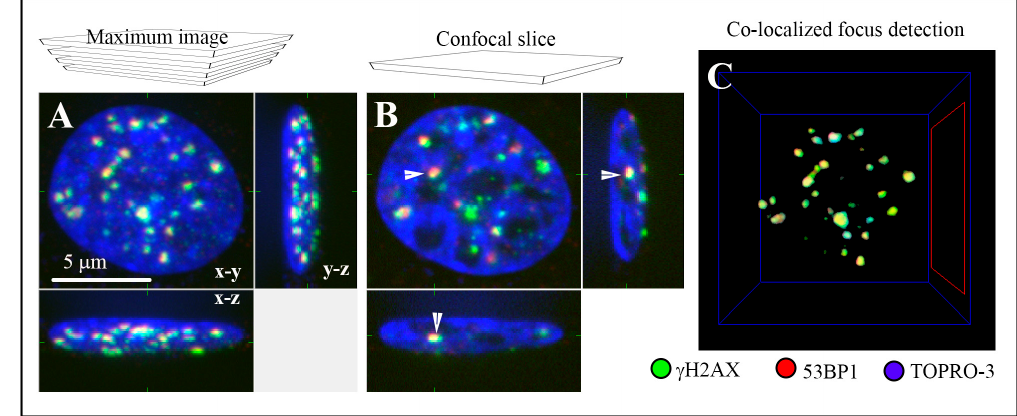
Figure 1. The ability of immunofluorescence confocal microscopy to quantify DSBs (Double Strand Breaks) in cells incubated with nanoparticles or incubated with nanoparticles and consecutively irradiated. DSBs were quantified by the means of immunofluorescence detection of co-localized γ H2AX (green) and 53BP1 (red) repair foci, the DSB markers. The nucleus of an illustrative U87 cell exposed to 2 Gy of γ -rays and spatially (three-dimensionally = 3D) fixed at 2 h post-irradiation (PI) is shown as: ( A ) a maximum intensity projection of 40 confocal slices (0.3 µ m thick; “maximum image”) or ( B ) a single confocal slice (0.3 µ m thick) intersecting the indicated (white arrow) γ H2AX/53BP1 focus. Images are displayed in all three (in the x-y, x-z and y-z) planes, and chromatin is counterstained with TO-PRO-3 (artificially blue). ( C ) An example of computational detection of co-localized (yellow) γ H2AX (green) and 53BP1 (red) repair foci in 3D space (Aquarium Software).